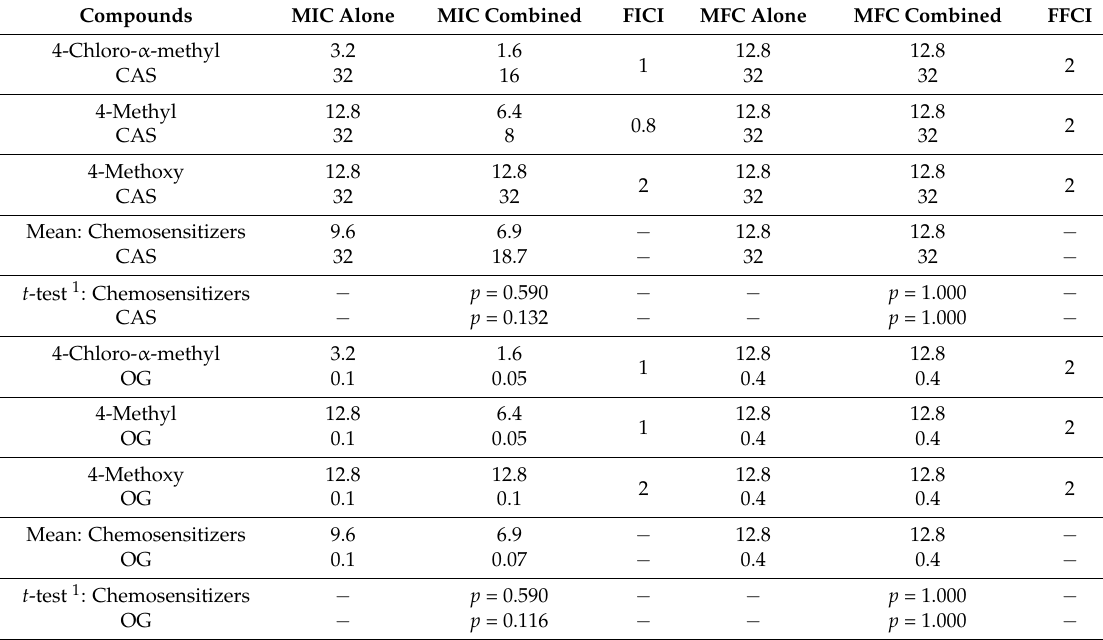
Table 3. Antifungal chemosensitization of 4-chloro- α -methyl- and 4-methylcinnamic acids to caspofungin (CAS) ( µ g/mL) or OG (mM), tested against Aspergillus brasiliensis : Summary of Clinical Laboratory Standards Institute (CLSI) bioassays.